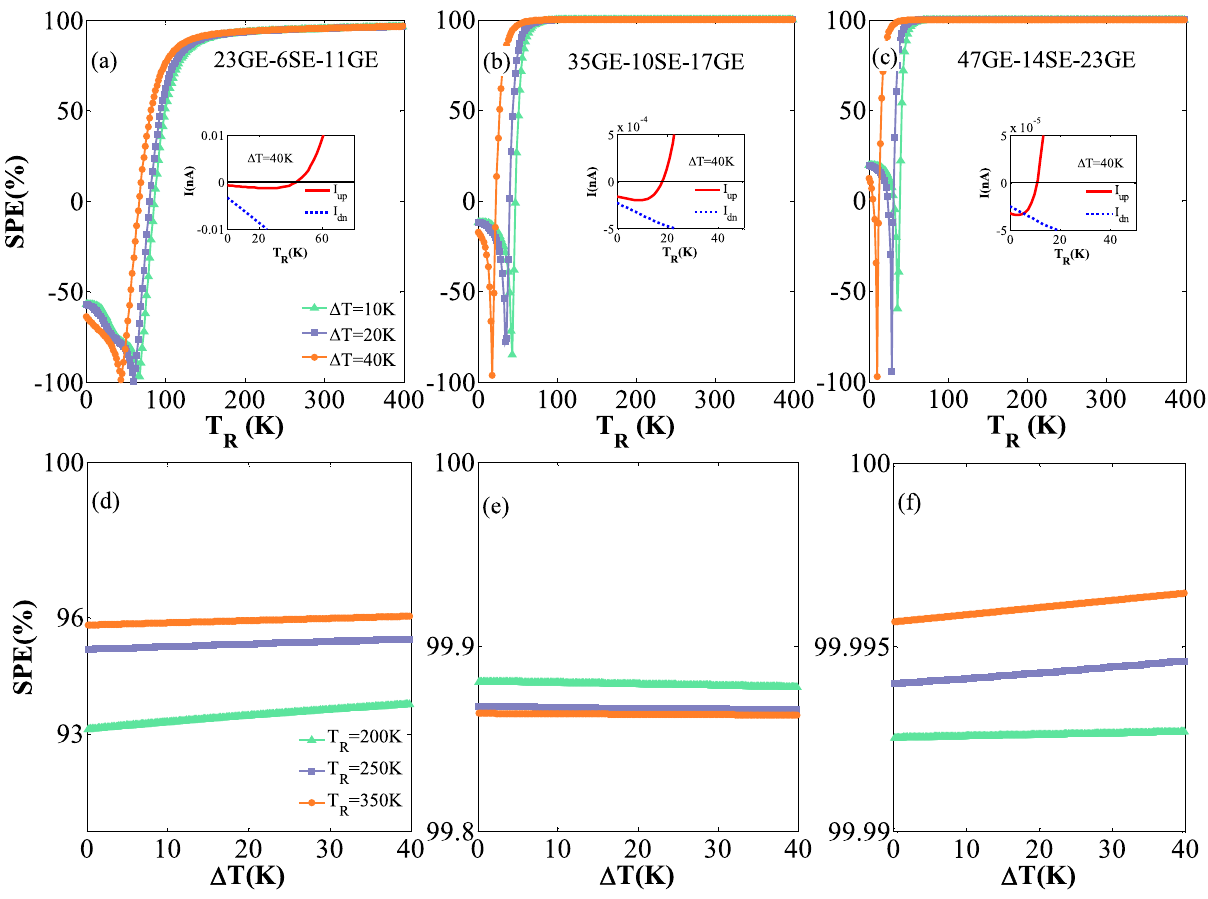
Figure 3. Panels ( a ), ( b ), and ( c ) show the variation of the SPE against T R for ∆ T = 10, 20, and 40 K; Panels ( d ), ( e ), and ( f ) show the SPE variation against ∆ T for T R = 200, 250, and 350 K for the 23GE-6SE-11GE, 35GE-10SE- 17GE, and 47GE-14SE-23GE configurations, respectively. The insets show the I up reverse sign and the mutual competition among I up and I dn for T R < 100 K and ∆ T = 40